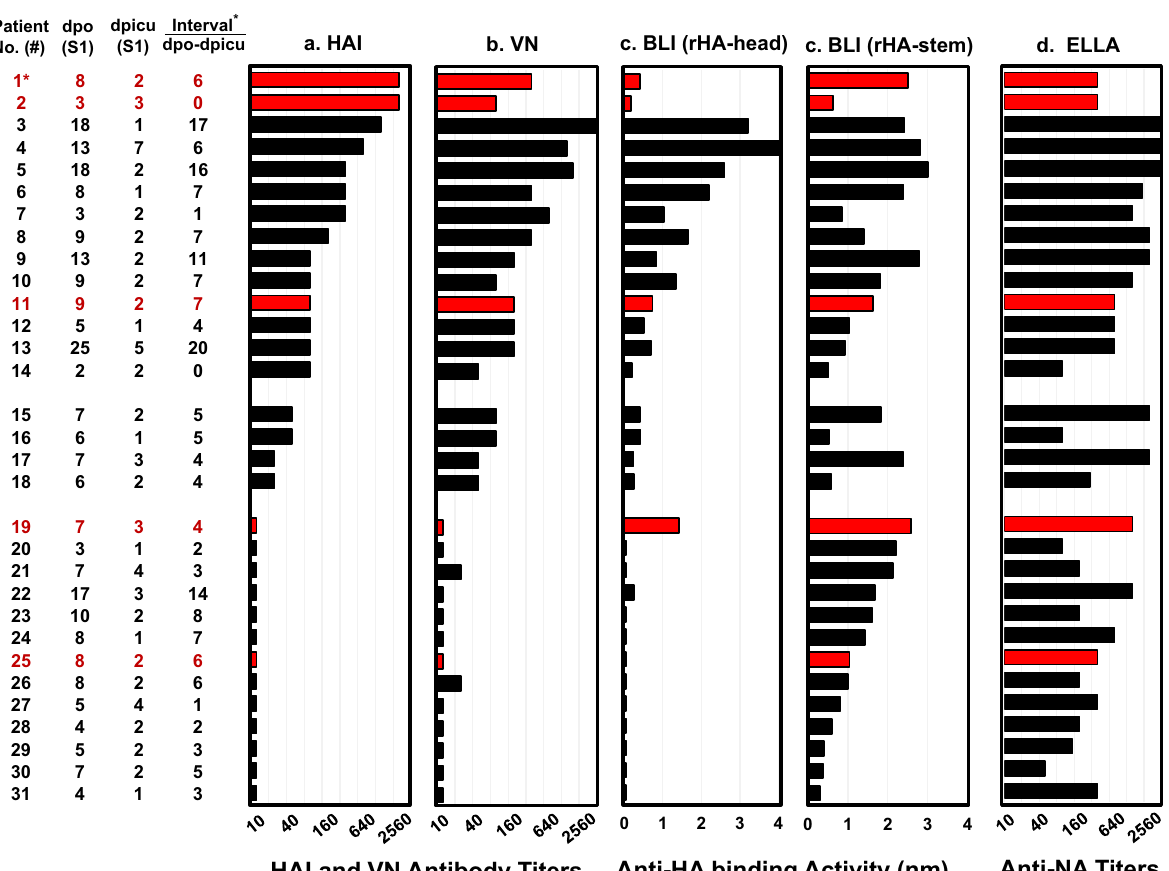
Figure 1. A(H1N1)pdm09 virus infections induced low quality antibody responses in most patients at the time of ICU admission. The first serum samples (S1) collected 1 to 7 days post ICU admission (dpicu) and 2 to 25 days post-symptom onset (dpo) from 31 patients were tested by: ( a ) HAI assays using wt-CA/09 (Q223), ( b ) VN assays using MX/09 (Q223QR); ( c ) BLI assays using rHA-head from wt-CA/09 and rHA-stem from A/ Michigan/45/2015, and ( d ) ELLA assays using A(H6N1) reassortant virus possessing wt-CA/09 NA. Antibody responses are illustrated by black bars for survivors and red bars for patients with fatal outcomes. For each sample, we completed three independent HAI and VN assays. ELLA assays were performed in duplicate. BLI assays were performed in 2 independent assays. *The interval between S1 dpo and S1 dpicu, and fatal patients in